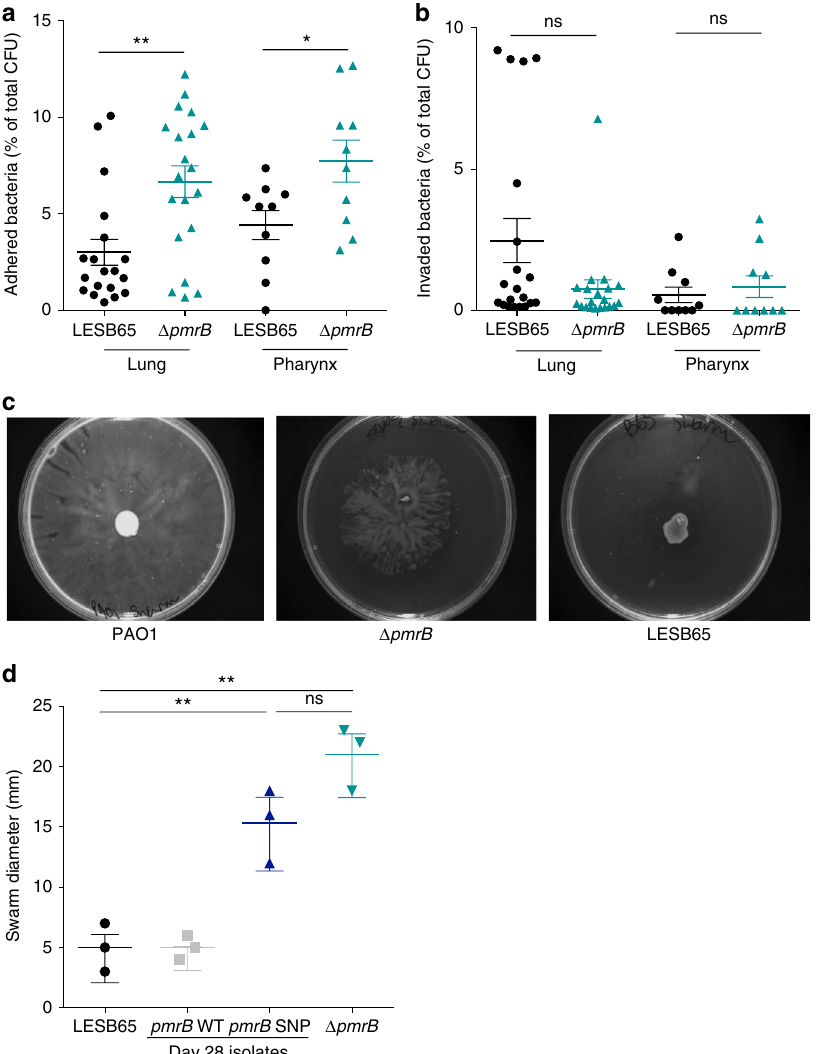
Fig. 5 Pili-dependent processes in LESB65 and Δ pmrB . a Adhesion and ( b ) invasion of LESB65 and Δ pmrB to A549 human alveolar epithelial cells (lung) and human Detroit pharyngeal cells (pharynx). Results are expressed as a percentage of total bacterial numbers per well. Data are a composite of four (lung) or two (pharynx) independent experiments, each containing 5 replicate wells per experimental group. c Swarming motility of PAO1, Δ pmrB , and LESB65 on semisolid agar. ( d ) Swarm diameter of isolates grown on semisolid agar. Data points shown are from three independent experiments. * p < 0.05, ** p < 0.01 and ns non-signi fi cant in unpaired t -test with Welch ’ s correction ( a, b ) or one-way ANOVA with Tukey post-test ( d Methods Bacterial isolates and gene deletion mutant isolates . LESB65 WT, pmrB WT and pmrB SNP were used and described in a previous study 6 . The LESB65 Δ pmrB mutant was created speci fi cally for this study. Upstream and downstream regions of pmrB were ampli fi ed using Q5 high fi delity DNA polymerase (NEB) using primer sets PmrB1_Xbal 5 ′ -TACTATTCTAGAGGACGACCTGCTGCTCG-3 ′ / PmrB2_Kpn1 5 ′ AATCCAGGTACCCGGGGGACTCCGGTAGGC-3 ′ – and PmrB3_Kpn1 5 ′ CCAAATGGTACCTAGCCTGCGCATTGGCCGGG-3 ′ / PmrB4_EcoRI 5 ′ CCTTGTGAATTCCGGCGAACGCCTGGAGCTA-3 ′ . Restric- tion sites are underlined. Following digestion with Xbal and Knp1 (upstream regions) or Knp1 and EcoRI (downstream region), the amplicons were ligated into the Xbal/EcoRI sites of pEX18Gm “ donor ” and transformed into Escherichia coli GT115 (selected on gentamicin 10mg per L). LESB65 WT and a helper E. coli GT115 (pRK2013) were grown on nutrient agar containing 25mg/L trimethoprim and 25 mg per L kanamycin respectively. P. aeruginosa LESB65 was grown at 42 °C and E. coli at 30°C, overnight. 1 ml of overnight culture was centrifuged at 6500 r.p. m. and resuspended gently in SOB. Recipient, donor, and helper were mixed at a ratio of 3:1:1 ratio and 150µl were pipetted onto the surface of a SOB plate. These were incubated for 20 h at 30 °C. Bacteria were removed from the plate and reinoculated onto agar plates containing 25mg per L trimethoprim and 200 mg per L gentamicin. Colonies were grown overnight and then negatively selected based on growth on 5% 9 (v/v) LB Sucrose (with trimethoprim and gentamicin) plates.